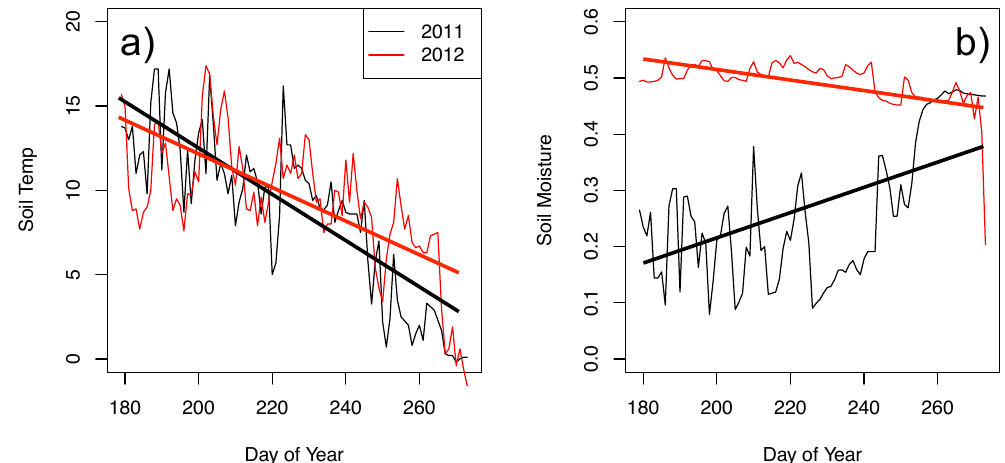
Figure 6. Temporal variations in (a) soil temperature ( ◦ C) and (b) soil moisture (m 3 m − 3 ) , measured for tundra sites during the growing seasons of 2011 (black) and 2012 (red). When soil temperature was below zero, at the end of September 2012, soil moisture dropped rapidly, as shown in Fig.